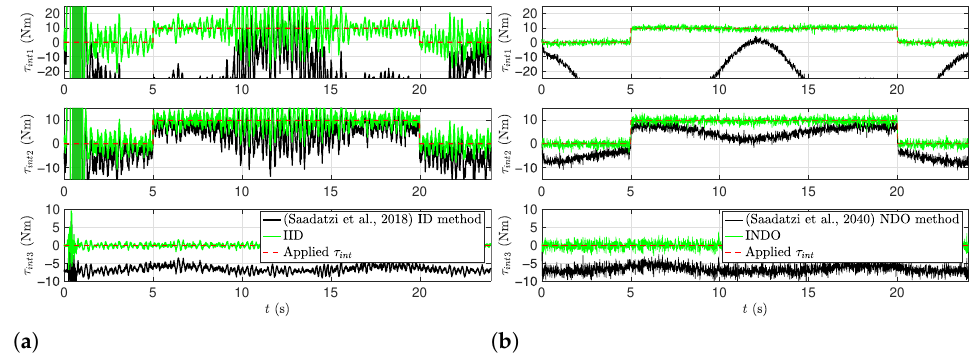
Figure 7. Comparison of ( a ) IID and Saadatzi et al. [12] ID method, and ( b ) INDO and Saa- datzi et al. [12] NDO method, during a squat exercise with SNR = 40dB and 20% BSIPs